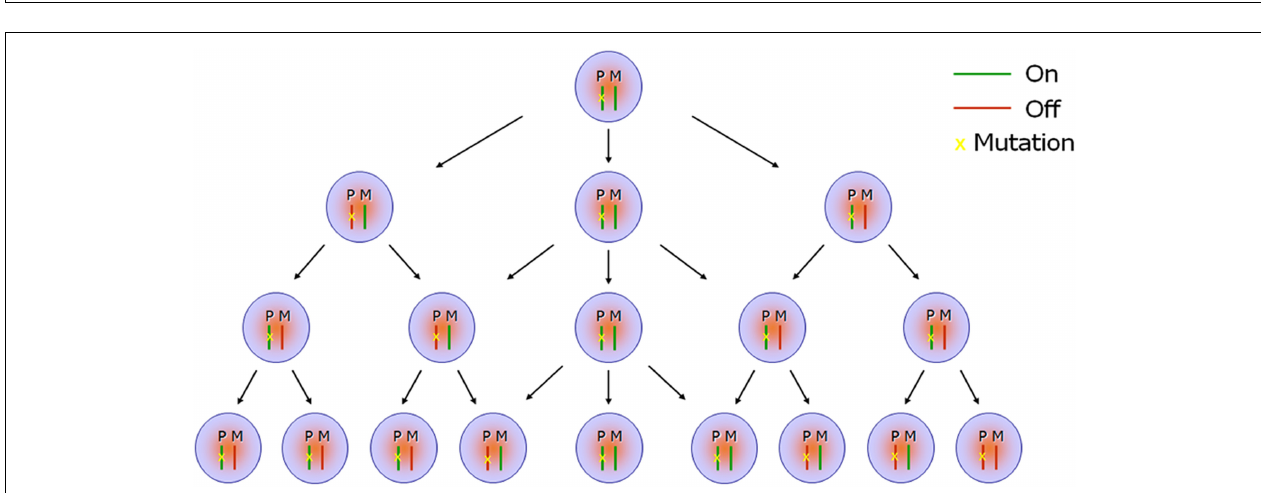
FIGURE 1 | RT-PCR products of single limb bud cells digested with Bsa OI. Single-cell RT-PCR products of limb bud cells were digested with Bsa OI (recognition sequence: CGRYCG). For paternally expressed allele (BALB/cJ with the sequence: CGACCG), the PCR products were specifically cut into two smaller fragments, 153 and 108 bp, while the PCR products with a full length of 261 bp were observed for the maternally expressed allele (C3H/HeJ with the sequence: TGACCG). PCR products displaying all three bands indicate biallelic expression in those particular cells. PCR products showing no readable signals are likely due to either low transcriptional level of the Tbx5 gene that fall below the detection threshold in single cells, or failure of single-cell lysis or nested RT-PCR.